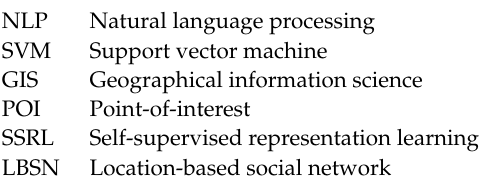
figshare. Journal contribution. https://doi.org/10.6084/m9.figshare.22082159.v2 accessed on 29 December